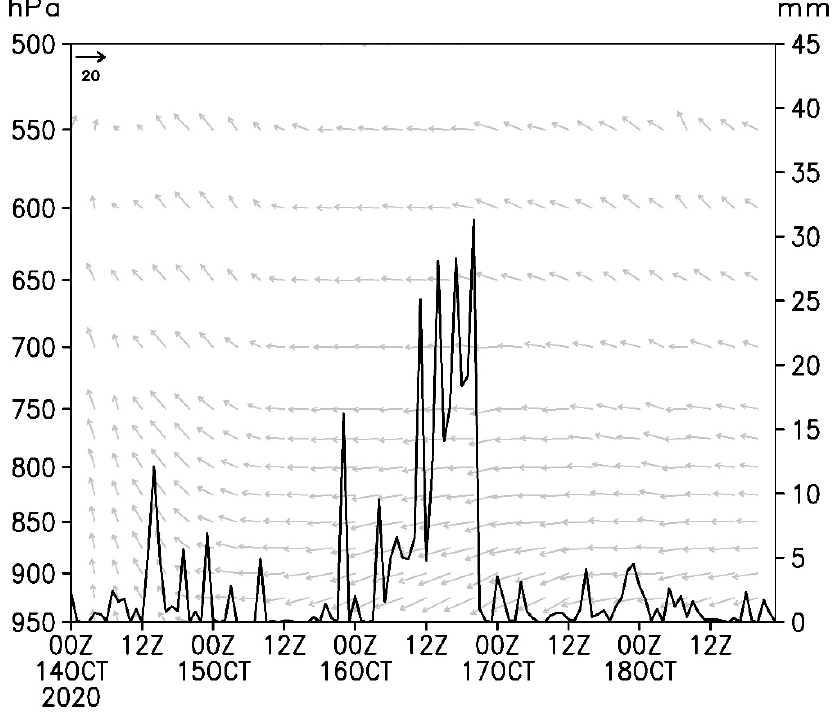
Figure 4. Pressure-time profile of horizontal wind (vectors, units: m · s − 1 ) overlaid with hourly precipitation (units: mm · h − 1 ) at Wanning (denoted by green triangle in Figure 1d).